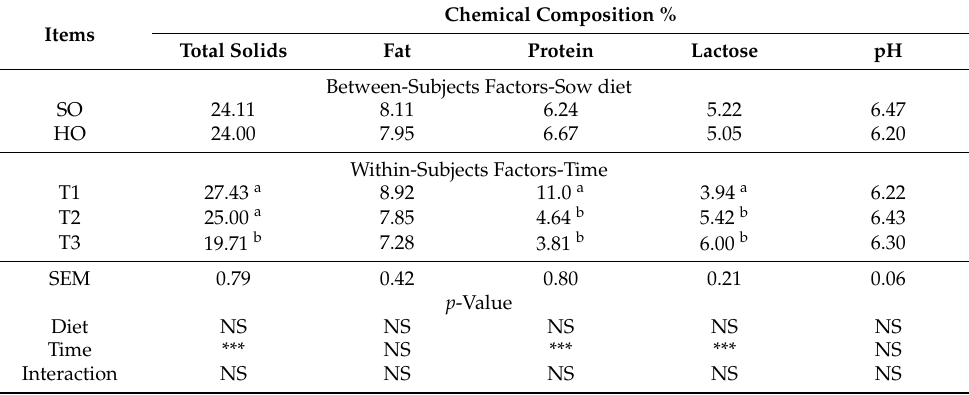
Abbreviations: standard error of mean, SEM; T1 = 12 h after farrowing, T2 = 10 days, T3 = 21 days. *** p ≤ 0.001 highly significant difference between means; a,b Different superscript letters indicate significantly different means ( p <